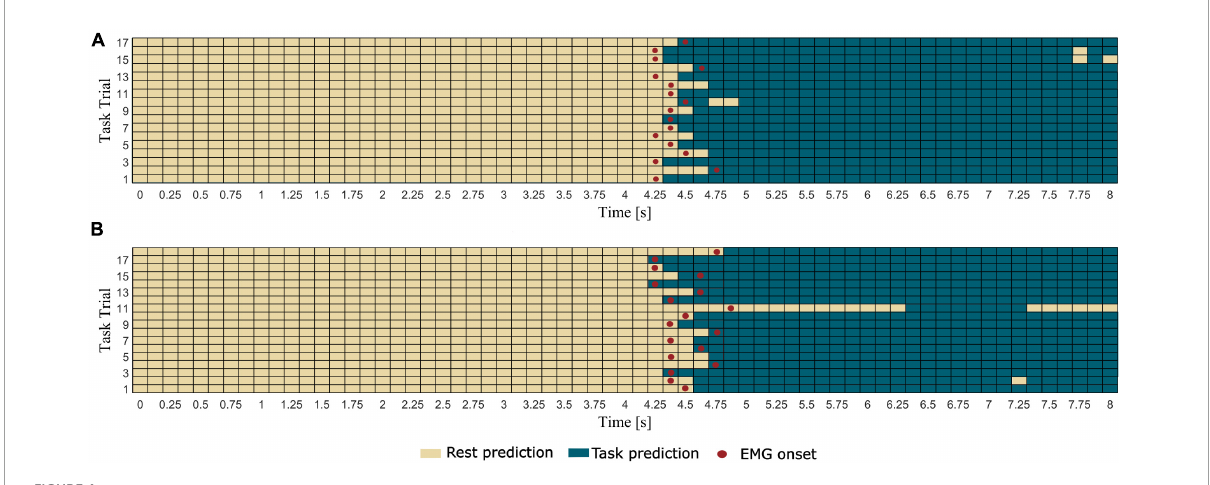
FIGURE4 Results of the pseudo-online classification (task vs. rest) performed for all the 57 windows in which each trial was epoched for a representative healthy participant (same as Figure 2 ) during (A) extension and (B) grasping of left hand. Rectangles represent the 1 s windows processed by the trained classifier one at a time every 125 ms. Windows predicted by the classifier as rest condition present light color, whereas windows predicted as task condition present dark color. The red dots indicate the first window including the EMG onset (i.e., which ends 125 ms after the EMG